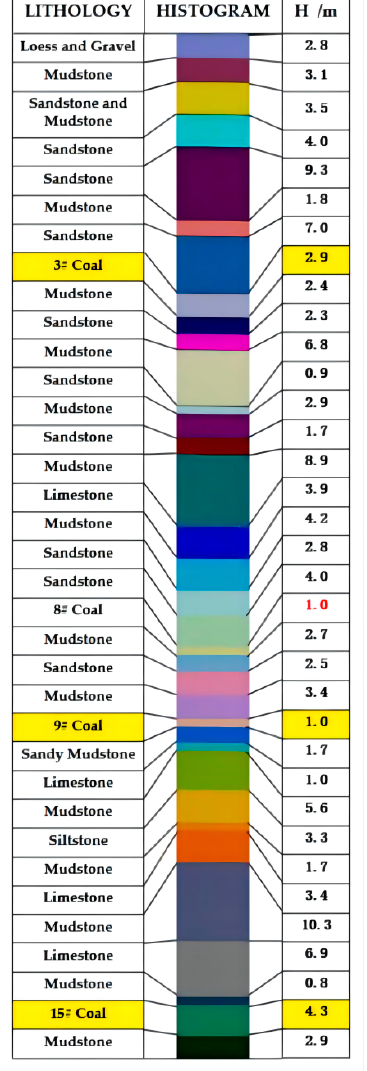
Figure 3. Comprehensive geological histogram of Majiazhuang mine.